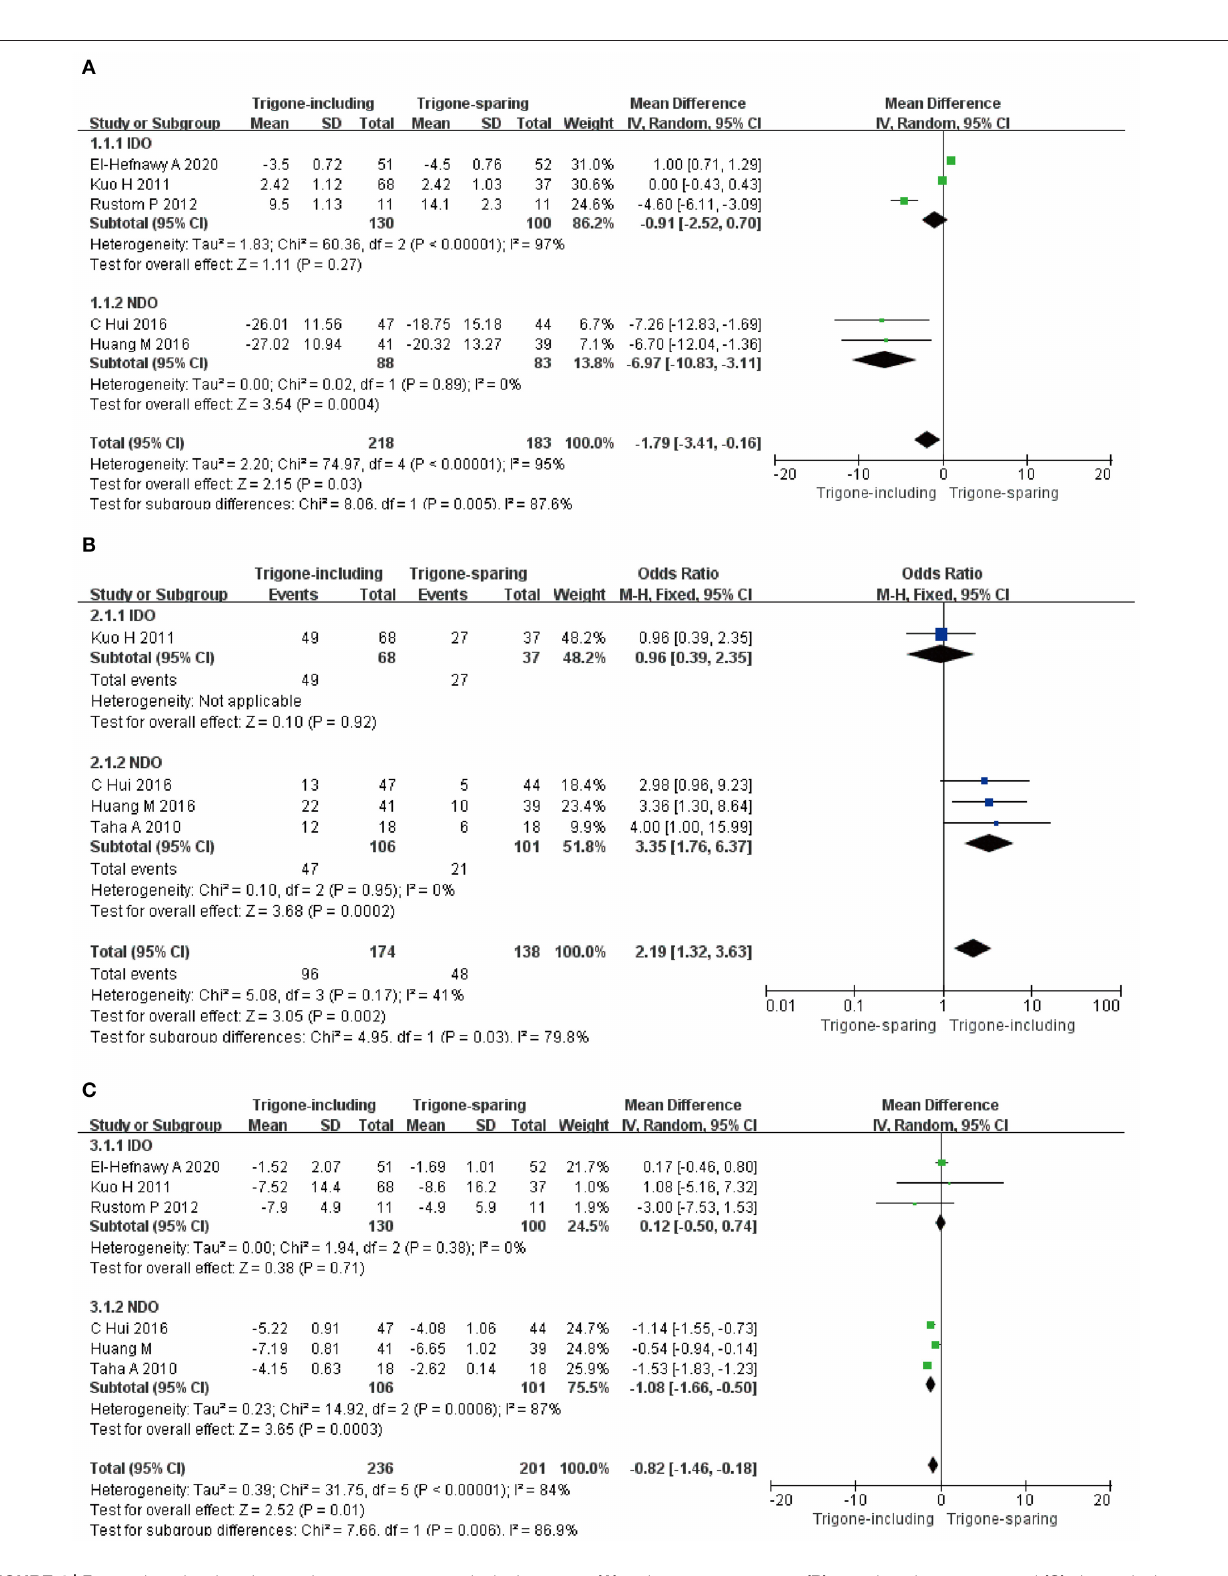
FIGURE 4 | Forest plots showing changes between two groups in the impact on (A) patient symptom score, (B) complete dryness rate, and (C) change in the number of incontinence episodes; NDO, neurogenic detrusor overactivity; IDO, idiopathic detrusor overactivity; SD, standard deviation; IV, inverse variance; CI, confidence interval; df, degrees of